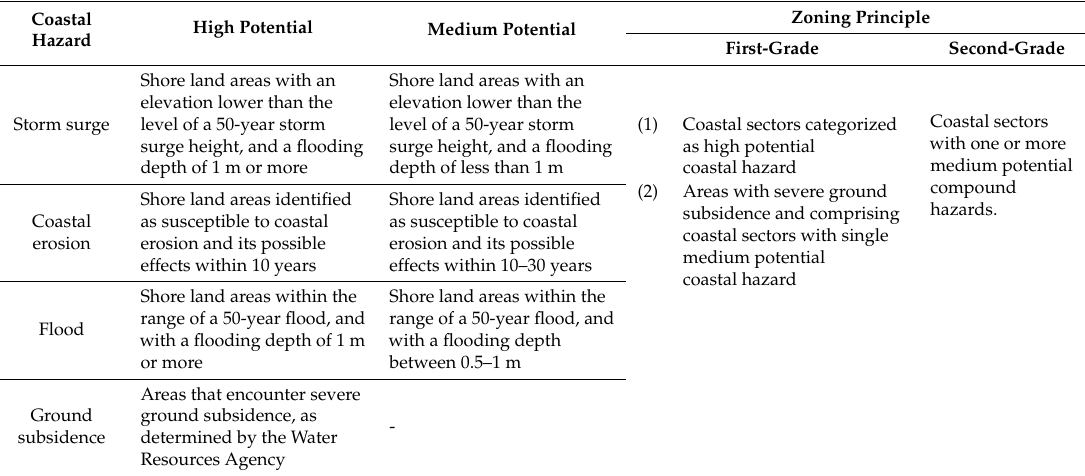
Table 1. Grading of coastal protection